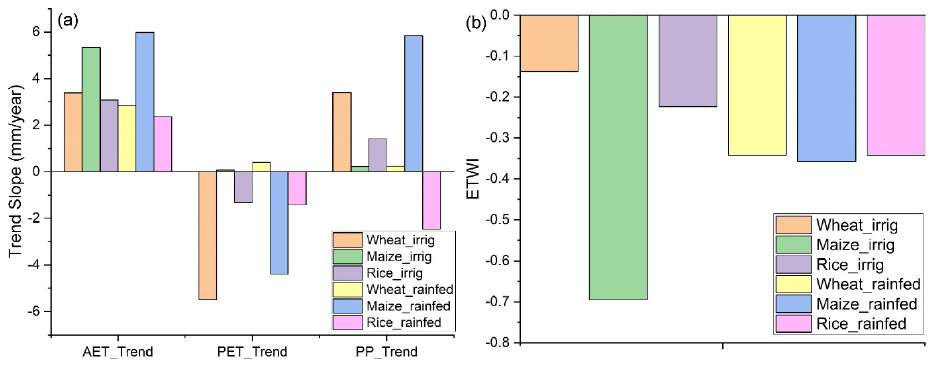
Figure 10. The trend of AET, PET, and PP in global major croplands. ( a ) trend slope; ( b ) ETWI.